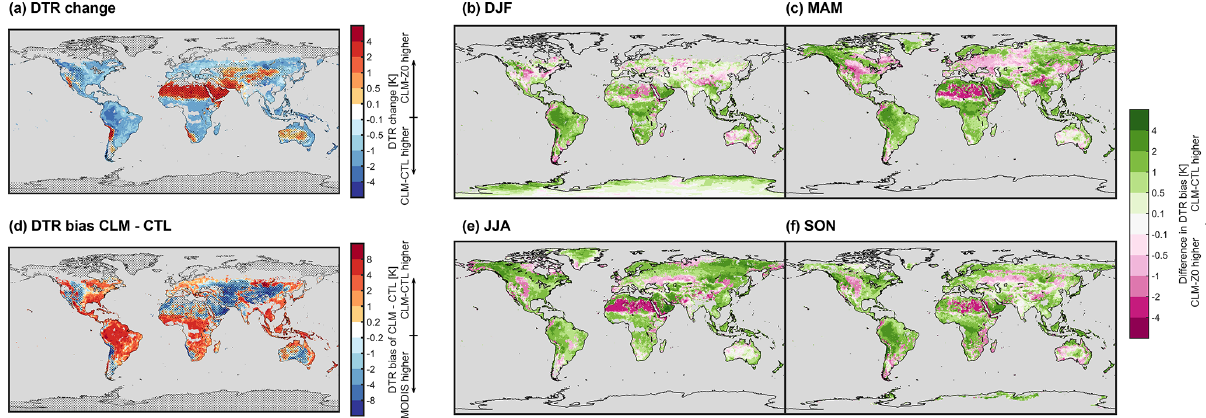
Figure 8. Panel (a) shows the difference in LST DTR of CLM-Z0 minus CLM-CTL and panel (d) bias in LST DTR of CLM-CTL compared to MODIS remote sensing observations. The stippling in those panels shows areas with an average VAI below 0.5m 2 m − 2 . To the right, the changes in the LST DTR bias between CLM-Z0 and CLM-CTL in boreal winter (b) , spring (c) , summer (e) , and autumn (d) are shown. CLM data are cloud masked based on the incoming shortwave radiation. Note the non-linear color